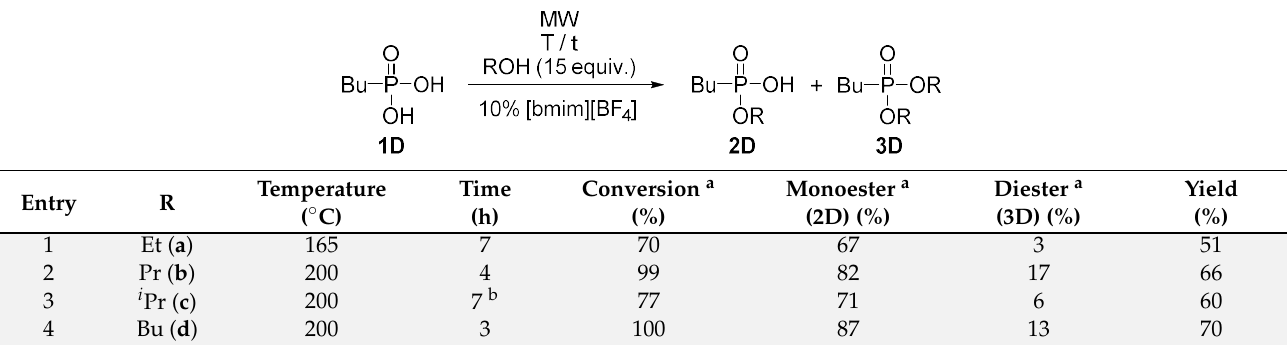
Table 4. Direct esterification of butylphosphonic acid ( 1D ) in the presence of [bmim][BF 4 ] on MW irradiation.